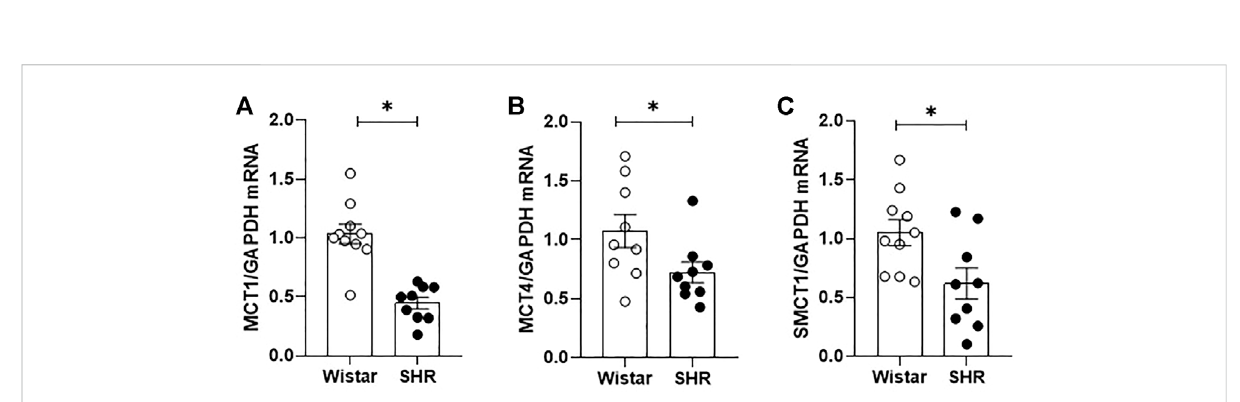
FIGURE 2 Impaired short chain fatty acids (SCFAs) intestinal absorption on adult SHR. Relative mRNA expression of (A) MCT1, (B) MCT4 and (C) SMCT1 transporters on proximal colon segments of adult Wistar and SHR, analyzed by qRT-PCR. The number of animals used in each group